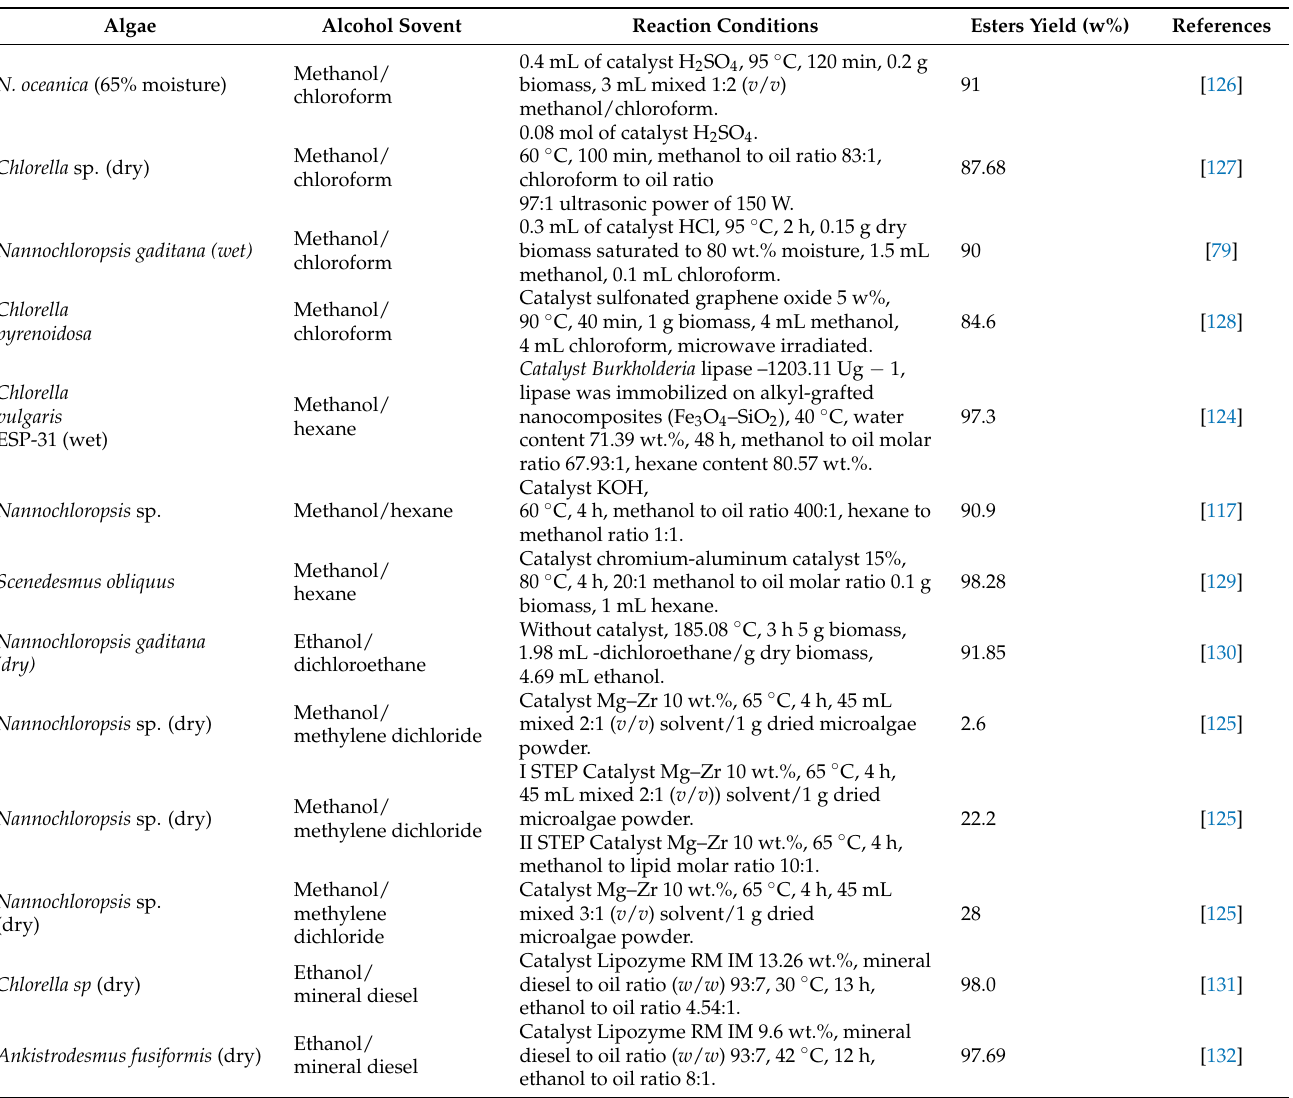
Table 10. Summary of solvents studied for in situ